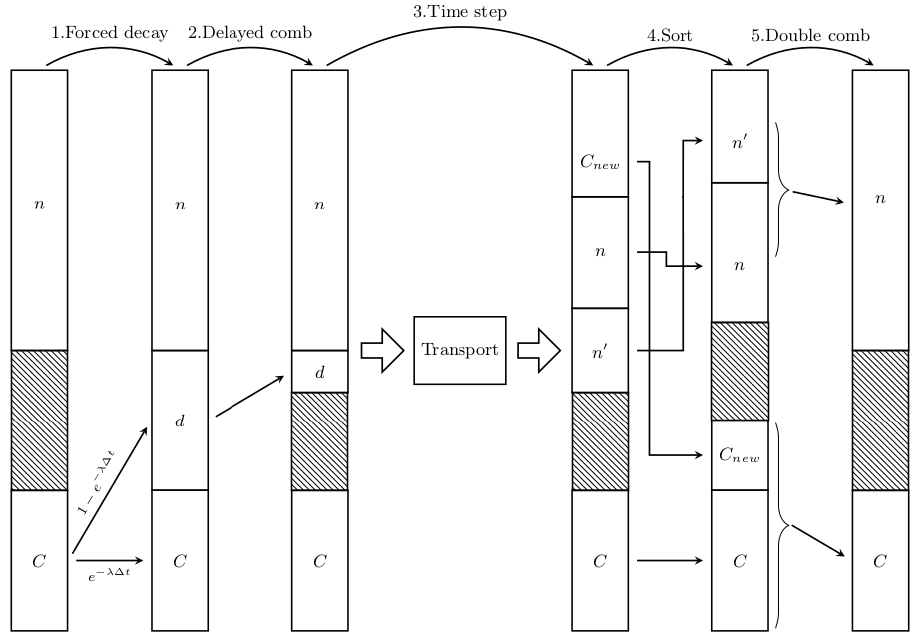
Figure 1. Prompt and delayed neutron handling